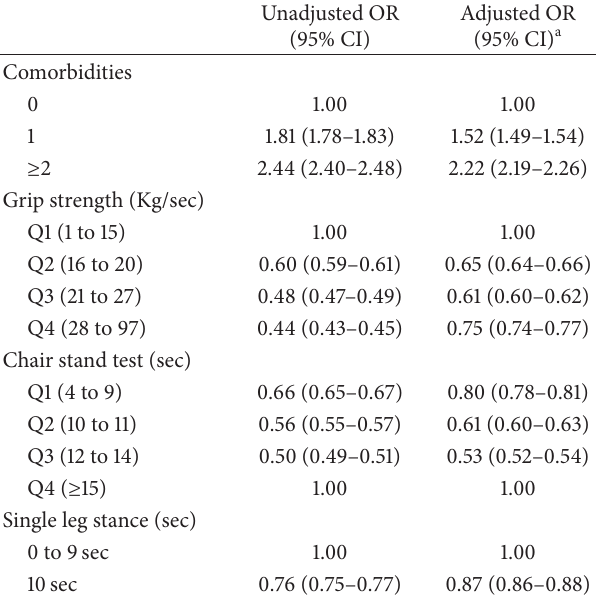
Table 2: Characteristics of participants associated with fall-related